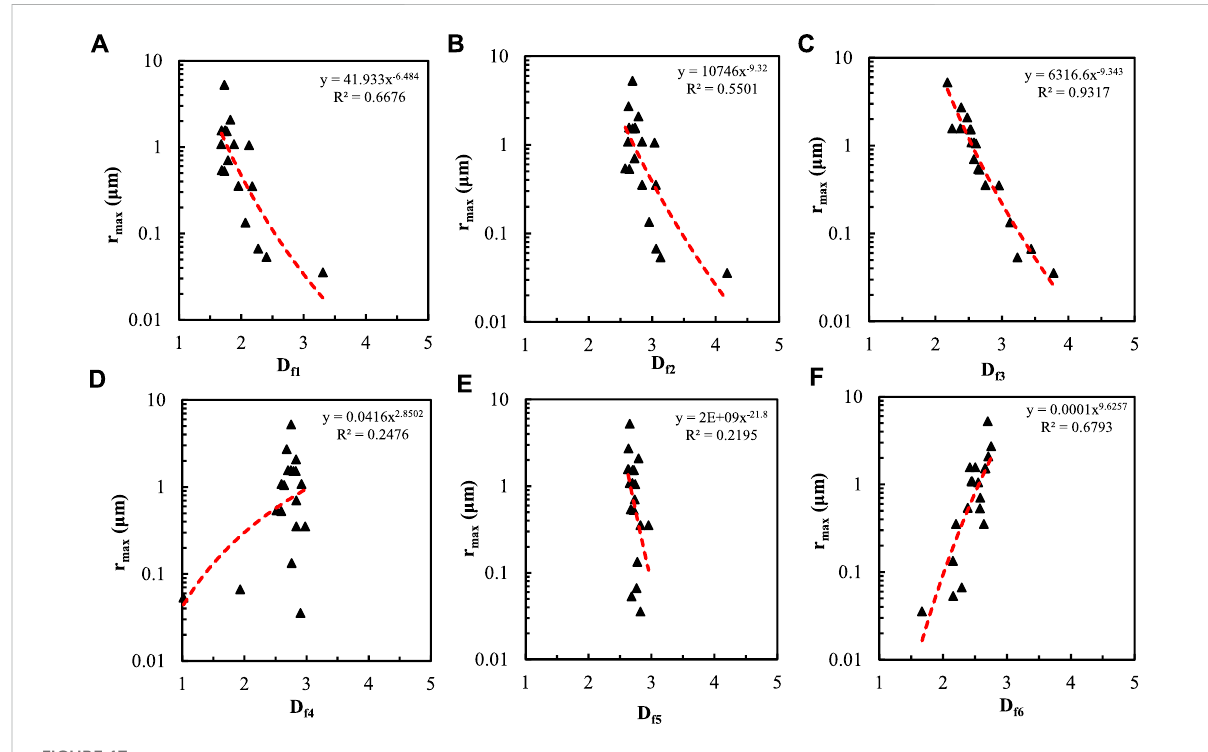
FIGURE 17 Relationship between maximum pore radius and fractal dimension calculated by six